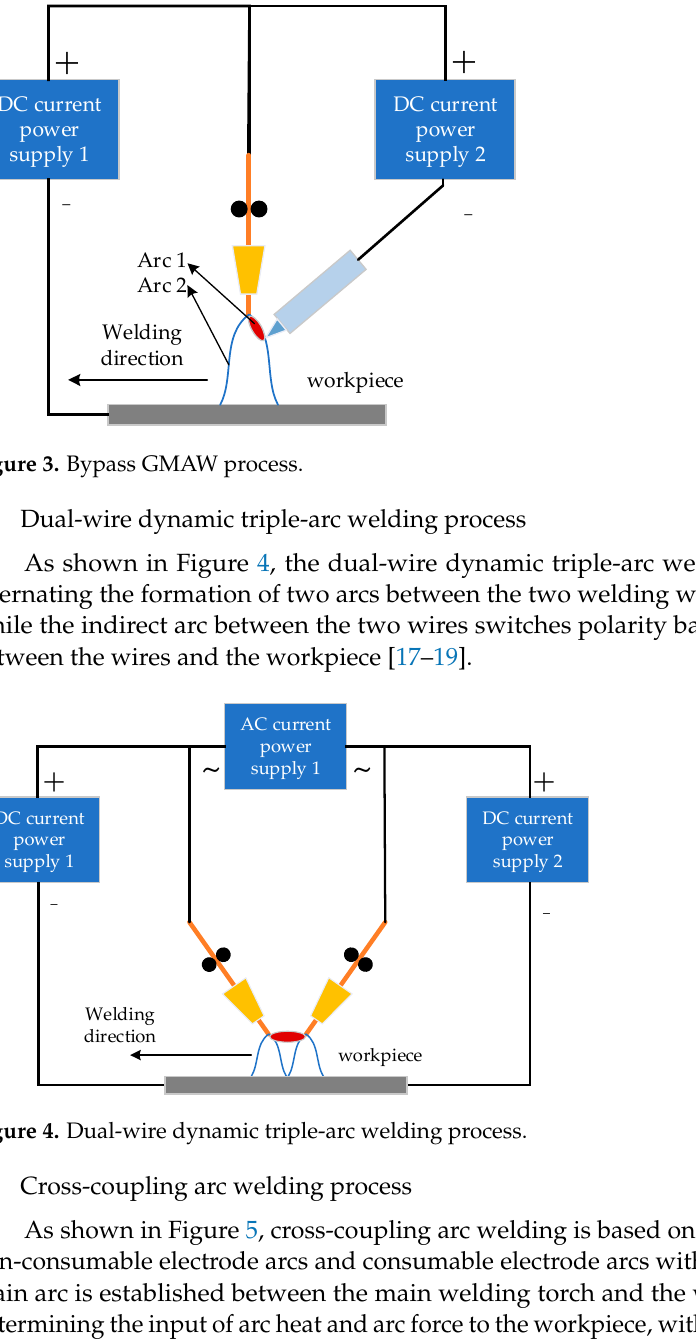
Figure 4. Dual-wire dynamic triple-arc welding process.